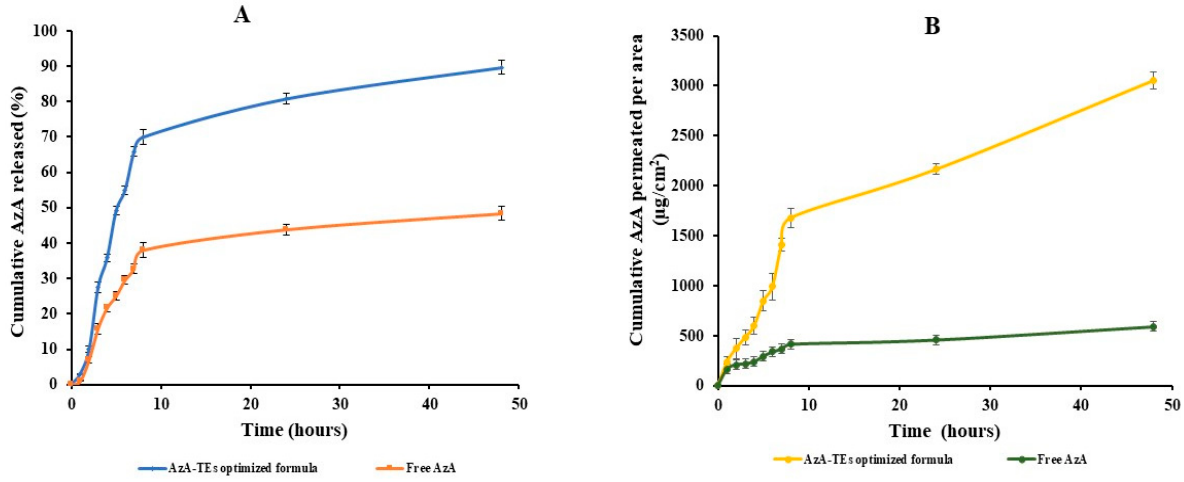
Figure 3. In vitro and ex vivo characterizations of the optimized formula; ( A ) In vitro drug release of the free AzA and the optimized AzA-TEs; ( B ) Ex vivo fluxes of the free AzA and the optimized AzA-TEs.